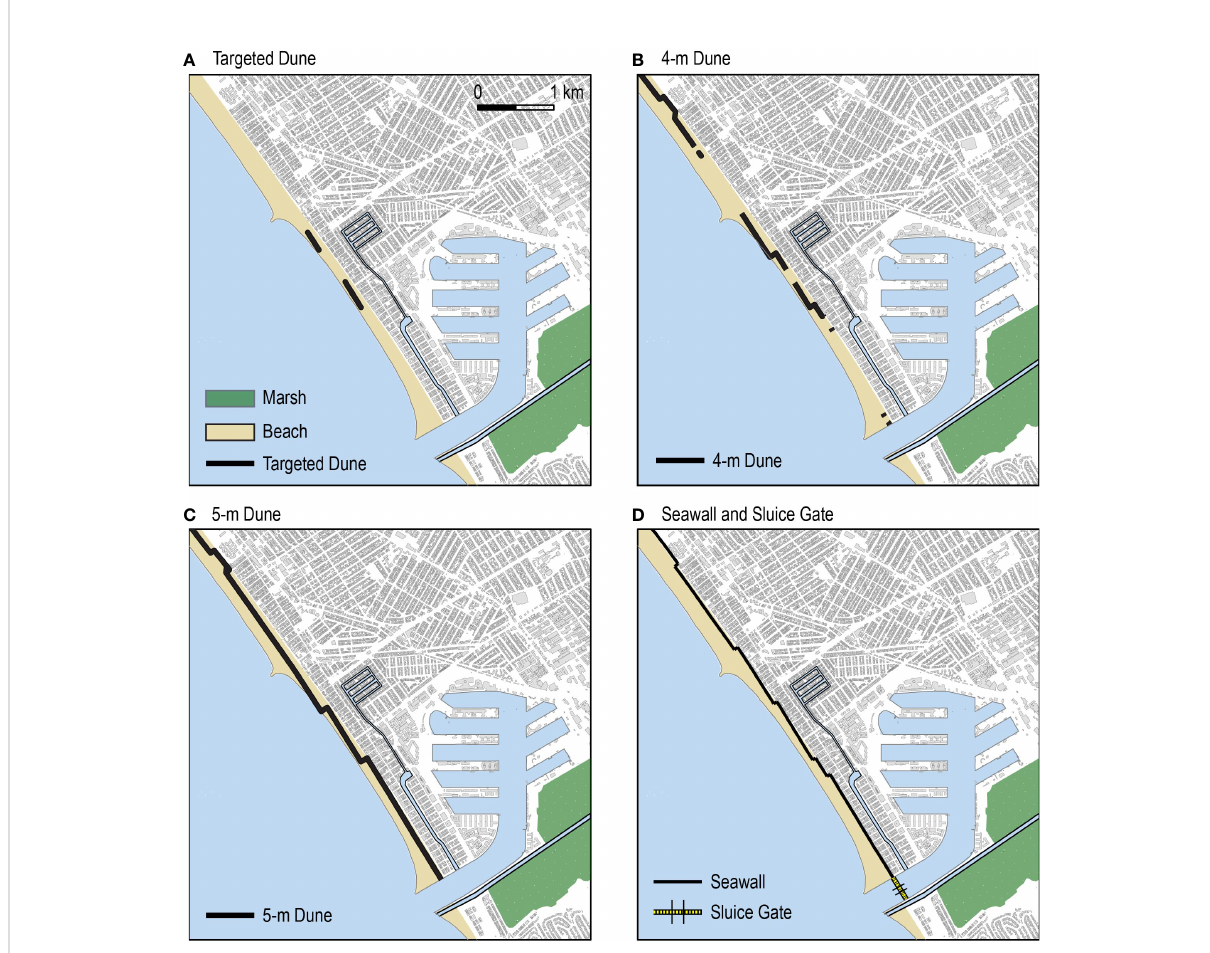
FIGURE 2 Coastal adaptation strategies implemented in the hydrodynamic model, including (A) targeted dunes, (B) dunes in beach locations under 4 m in elevation, (C) dunes in beach locations under 5 m in elevation, and (D) seawall and sluice